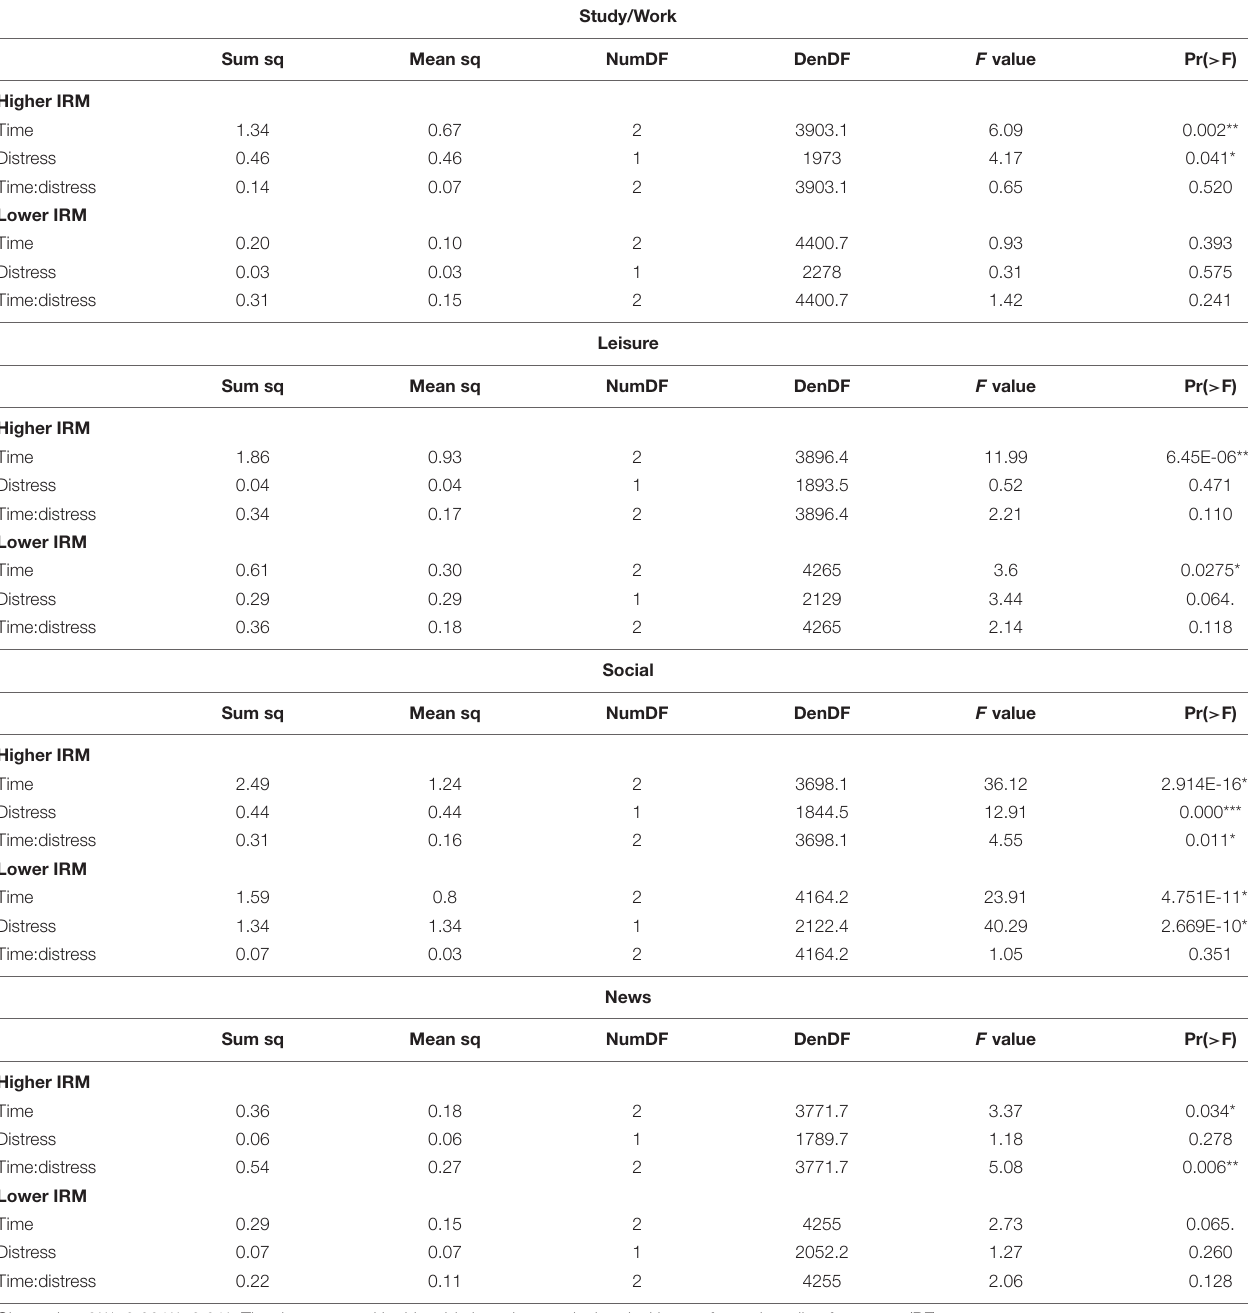
TABLE 4 | Effects of distress and time on RF for each type of reading and higher and lower IRM.